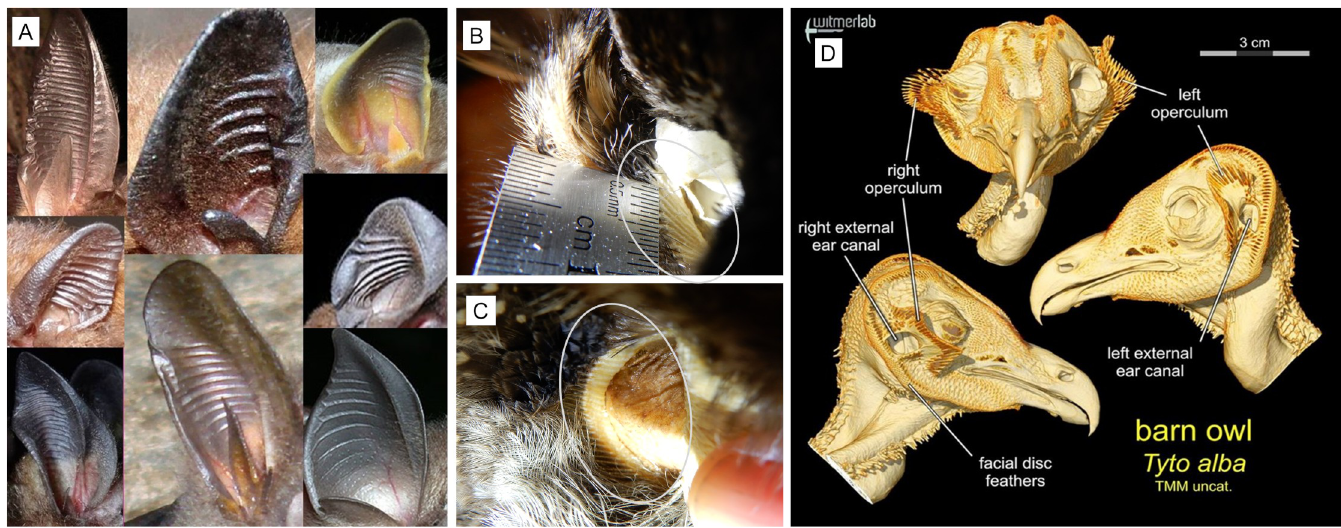
Fig 4. Groove array variations in the ears of bats and owls. (A) Groove array variations in bat pinnae. Owl museum specimen photos show periodic structures formed where quills anchor into the skin bordering the auditory openings for (B) Long-eared Owl (Asio otus), (C) Great Grey Owl (Strix nebulosa) and a computer rendering of (D) Barn Owl (Tyto alba) where feather shafts on the operculum and quill shafts bordering the auricular opening create periodic array structures.